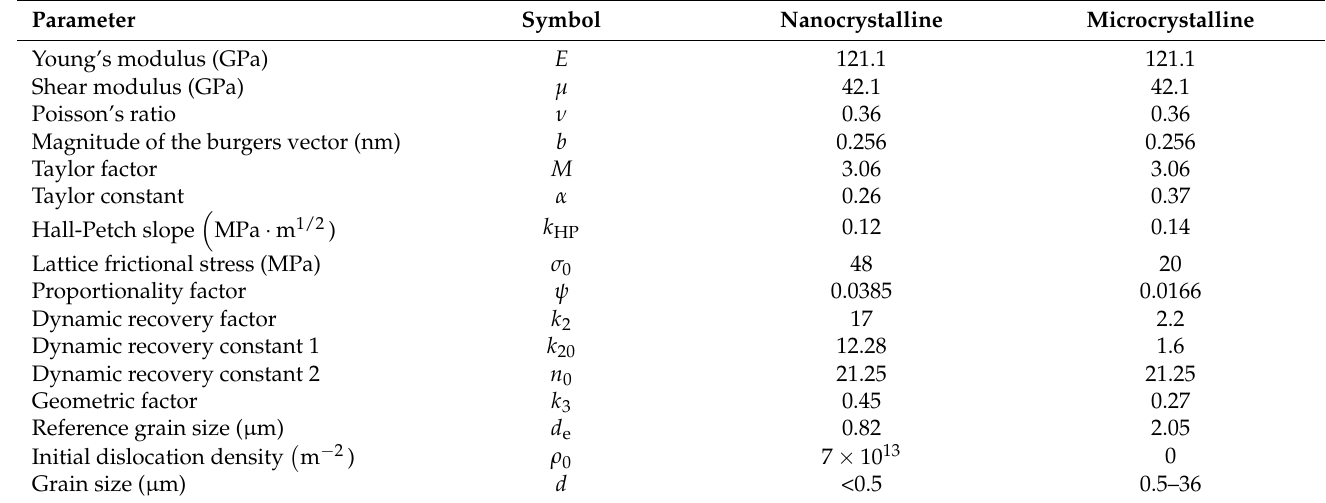
Table 1. Material parameters for the gradient